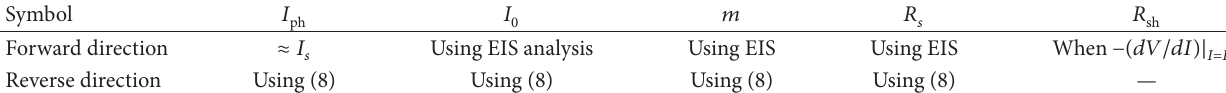
Table 2: Methods to estimate the numerical parameters used to fit experimental data to (8).